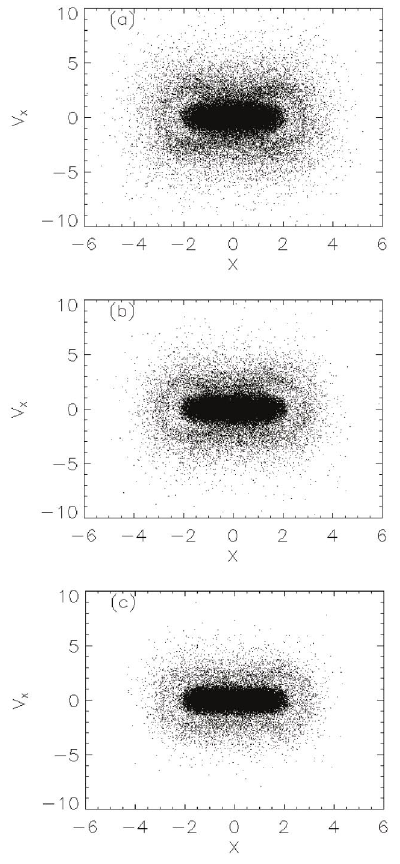
FIG. 8. Oscillation of the rms width of the beam with nonlinear focusing at last maximum rms width when S (cid:10) 300 for (cid:4) (cid:1) (cid:4) a (cid:5) 1.5, (b) 1.35, (c)